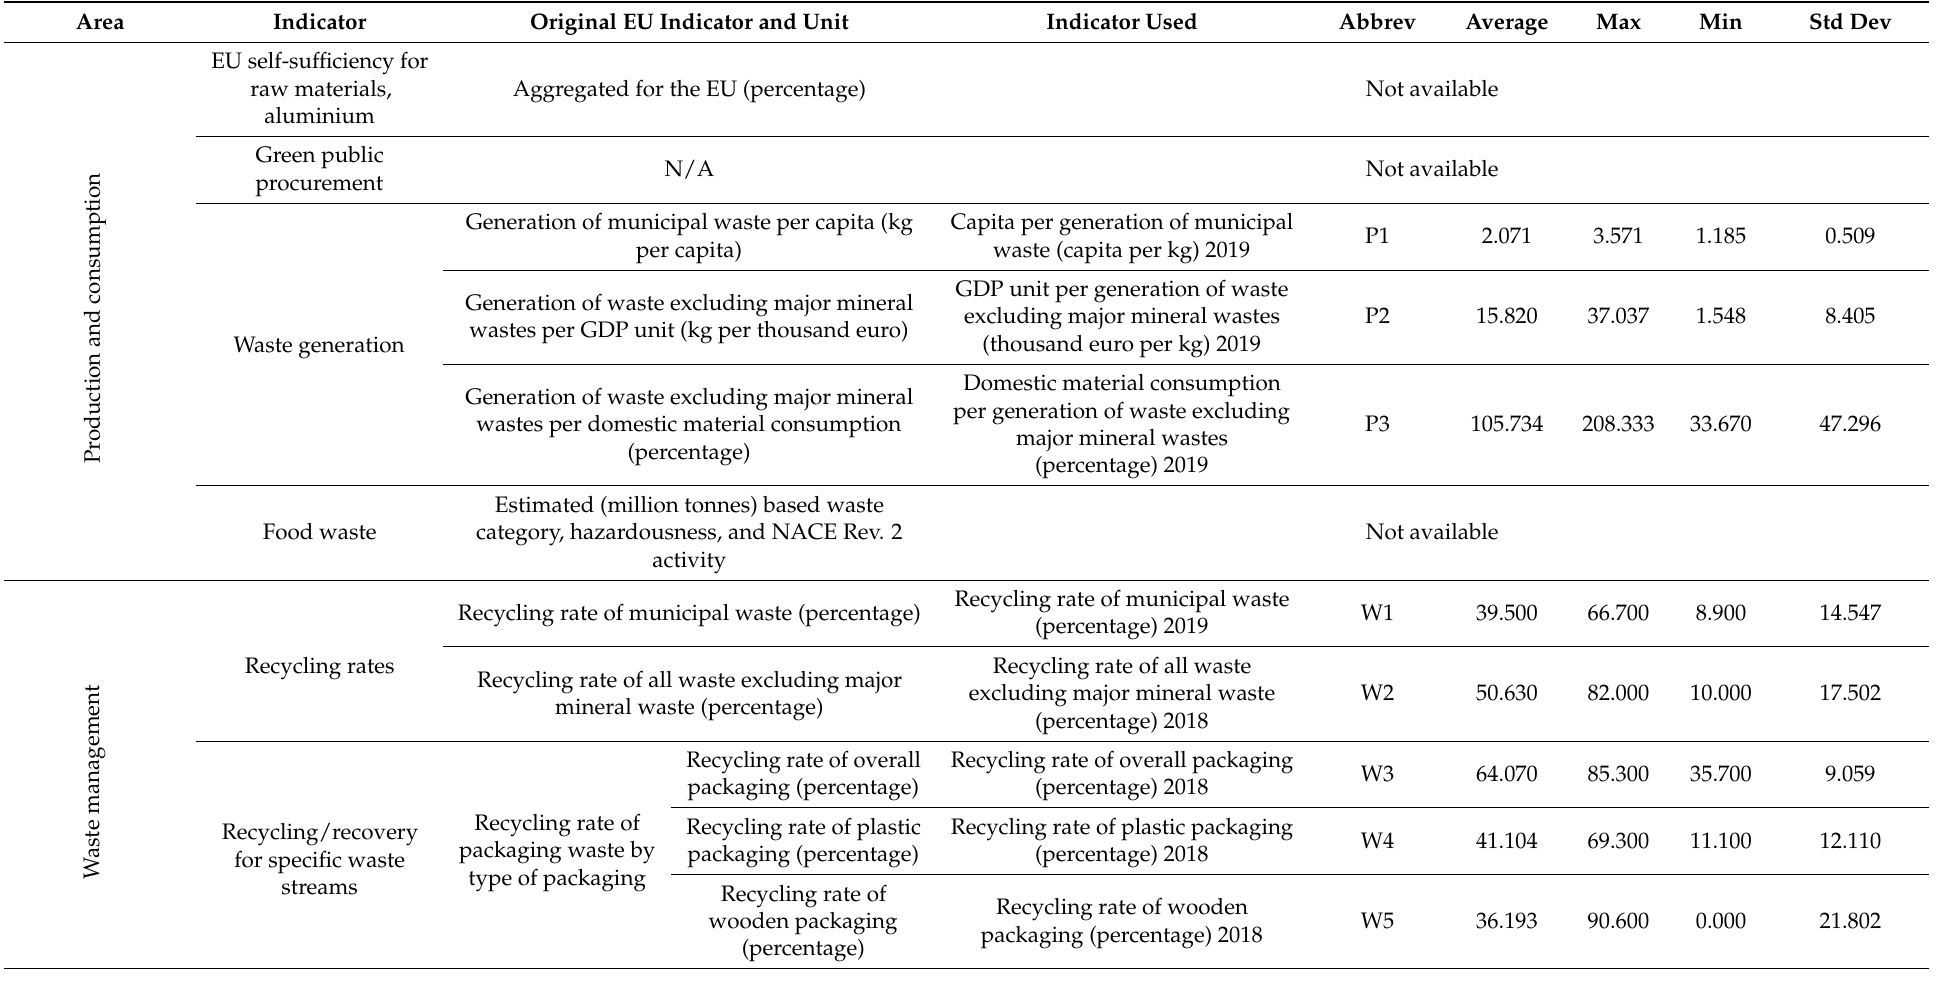
Table 2. EU CE monitoring framework data